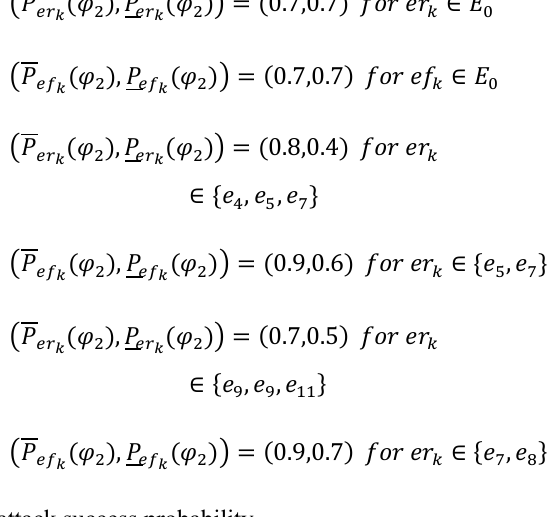
Table 6. Performance evaluation table for fake to fake